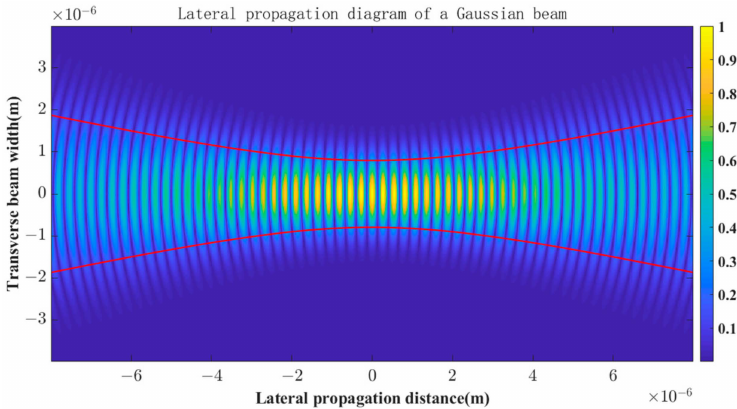
Figure 3. Lateral propagation diagram of the Gaussian beam.